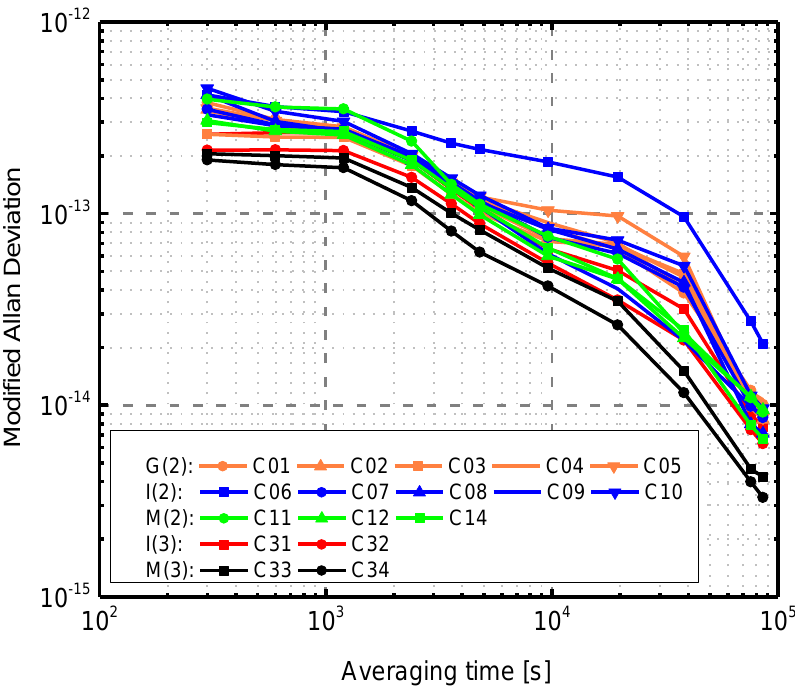
Figure 8. Modified Allan deviation of BDS-3 (C31–C34) satellite clocks for the time period DOY 204–223 (2016). For comparison purposes, the performance of the BDS-2 satellite clocks is also shown in the plot. G(2), I(2) and M(2) represent BDS-2 GEO (C01–C05 ), IGSO (C06–C10) and MEO (C11, C12, C14) satellites, and I(3) and M(3) represent BDS-3 IGSO (C31, C32) and MEO (C33, C34) satellites, respectively.